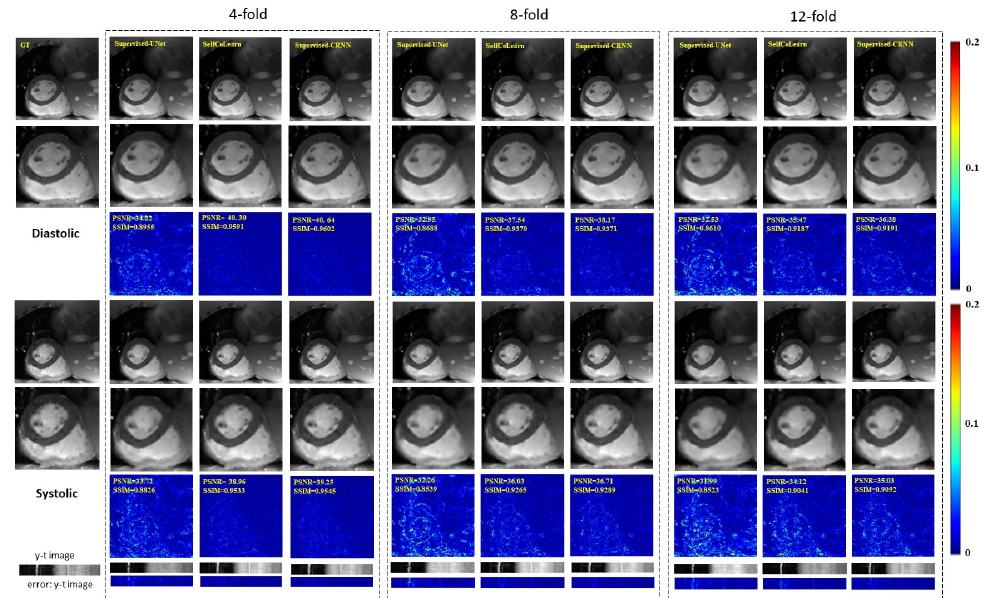
Figure 4. Reconstruction results of different methods (Supervised U-Net, SelfCoLearn, and Super- vised CRNN) at 4-fold acceleration, 8-fold acceleration, and 12-fold acceleration. The first row and fourth row show the ground truth (fully sampled image) and the reconstruction images of respective methods in the diastolic (the 10th frame of the image sequence) and systolic (the 5th frame of the image sequence), respectively. The second row and fifth row show their corresponding enlarged images in the heart regions. The third row and sixth row plot the error images of the corresponding methods. The last two rows show y-t images (the 40th slice along the dimensions of y and t) and the corresponding error